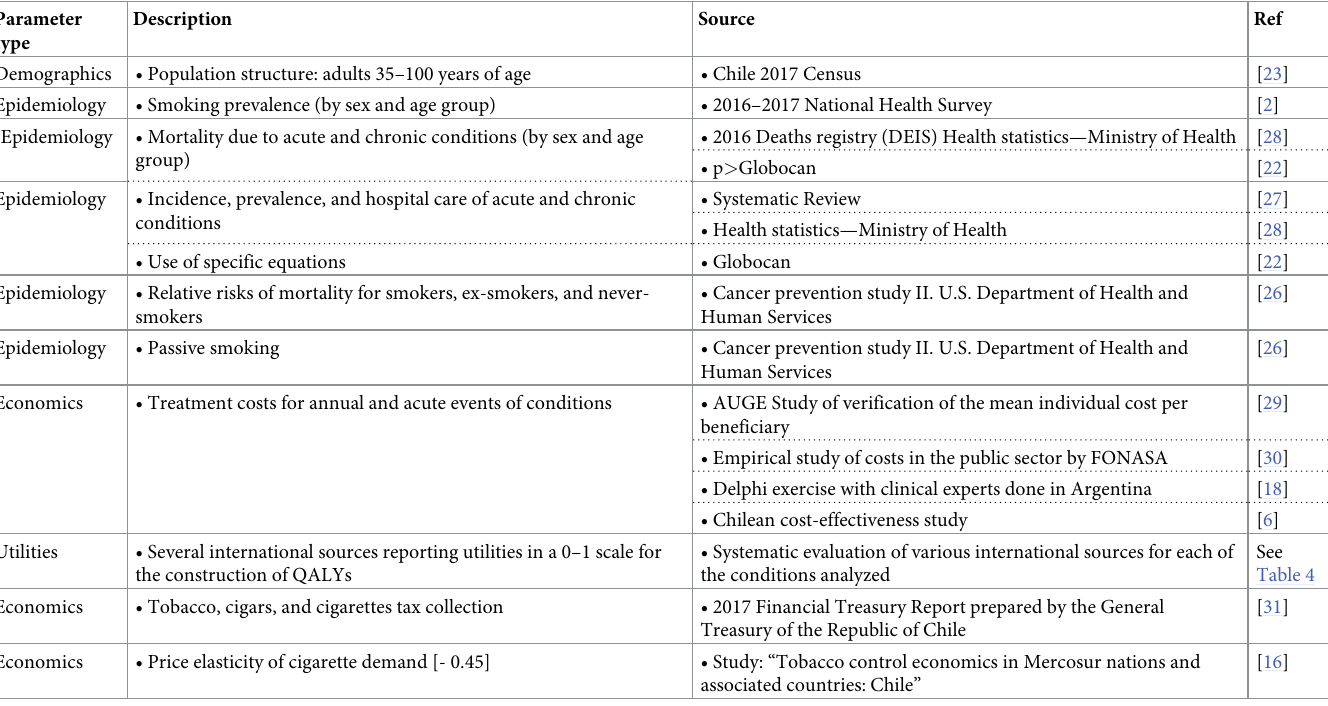
Table 1. Overview of main sources for model input parameters, by